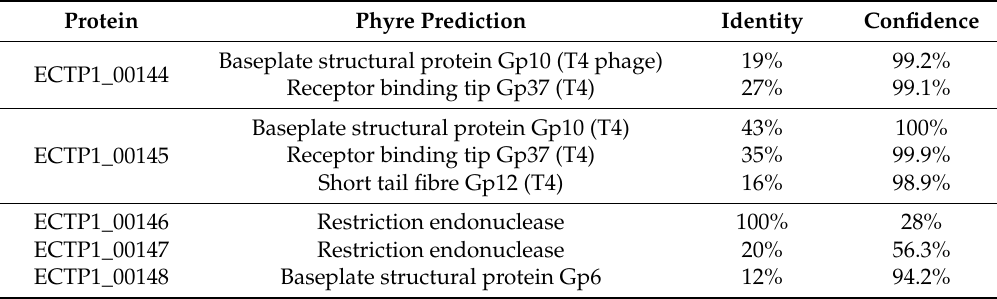
Table 1. Phyre analysis of the putative ECTP1 RBPs isolated from the